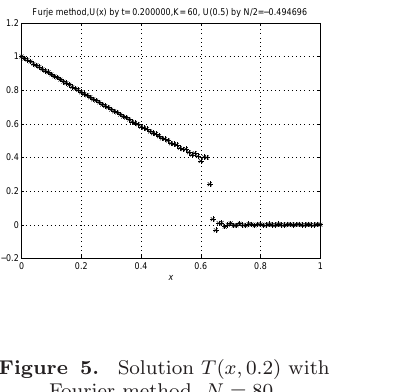
Figure 6. Solution T ( x,t ) with Fourier method, N =